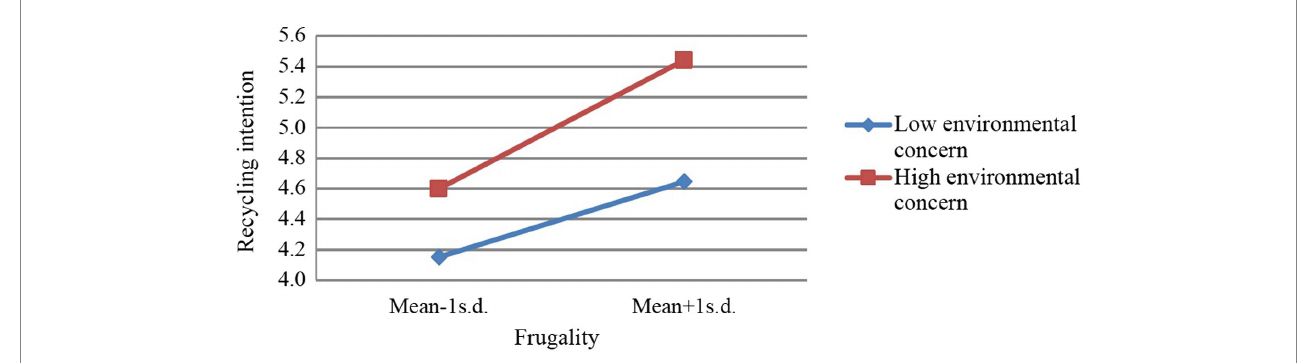
FIGURE 2 The moderating effect of environmental concern on the relationship between frugality and recycling